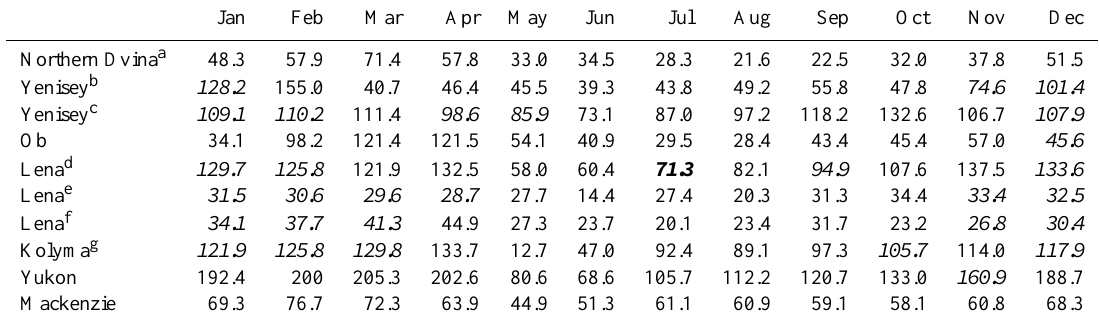
Table A3. Monthly-binned riverine concentrations of silicate (mmolSim − 3 ) . Linearly interpolated values are shown in italic. Jan Feb Mar